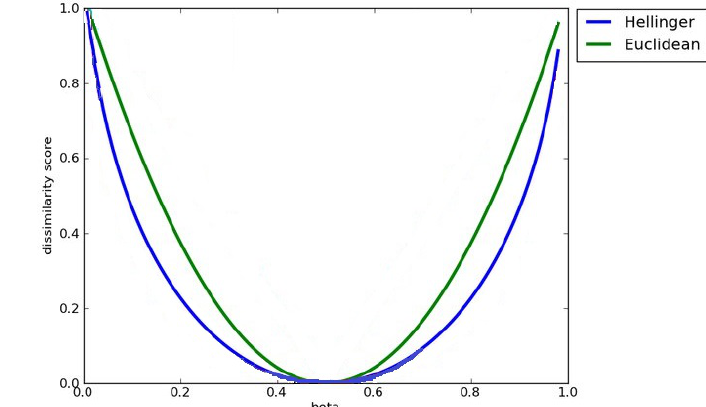
Figure 7. The behavior of the Squared Hellinger